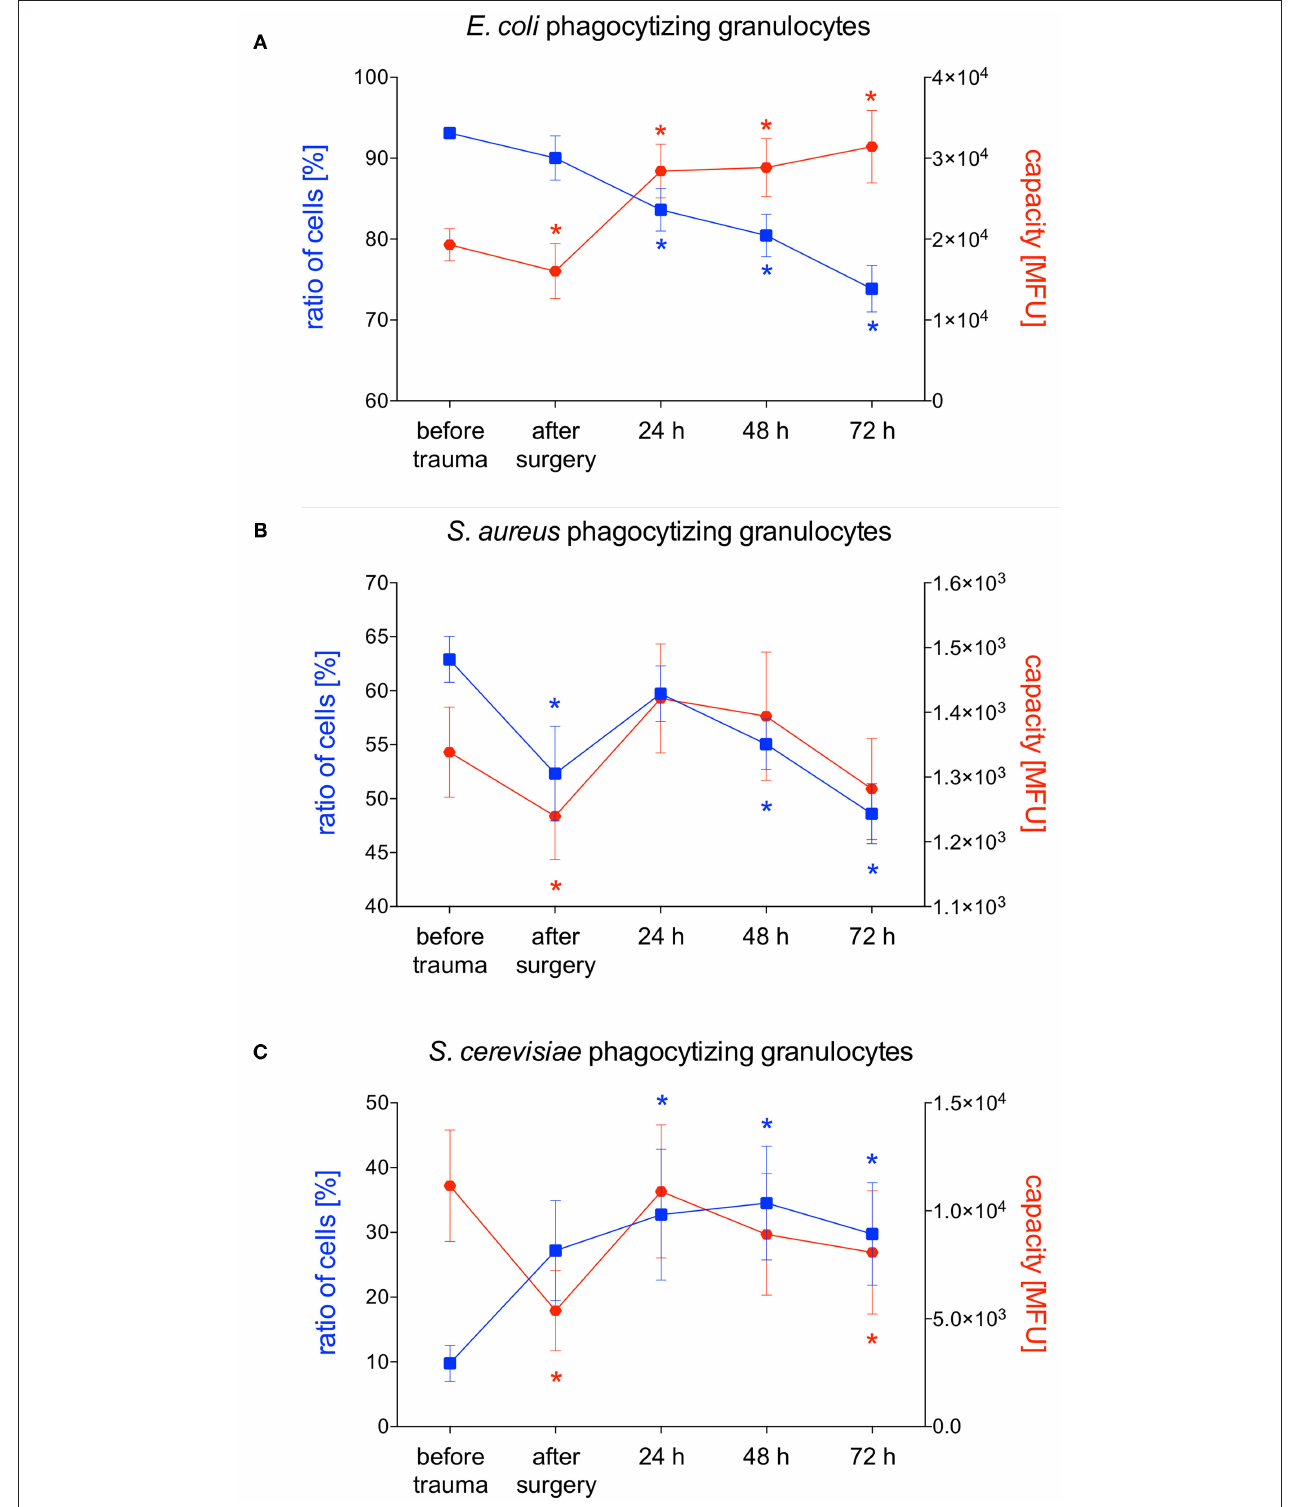
FIGURE 4 | Percentage of phagocytizing granulocytes and phagocytic capacity for E. coli , S. aureus or S. cerevisiae . The percentage of phagocytizing granulocytes and their capacity to phagocytize E. coli (A) , S. aureus (B) or S. cerevisiae (C) was measured with FACS-analysis before trauma, after trauma and after 24, 48 and 72h. Data are given as mean ± standard error of the mean, * p < 0.05 vs. baseline, n = 8.